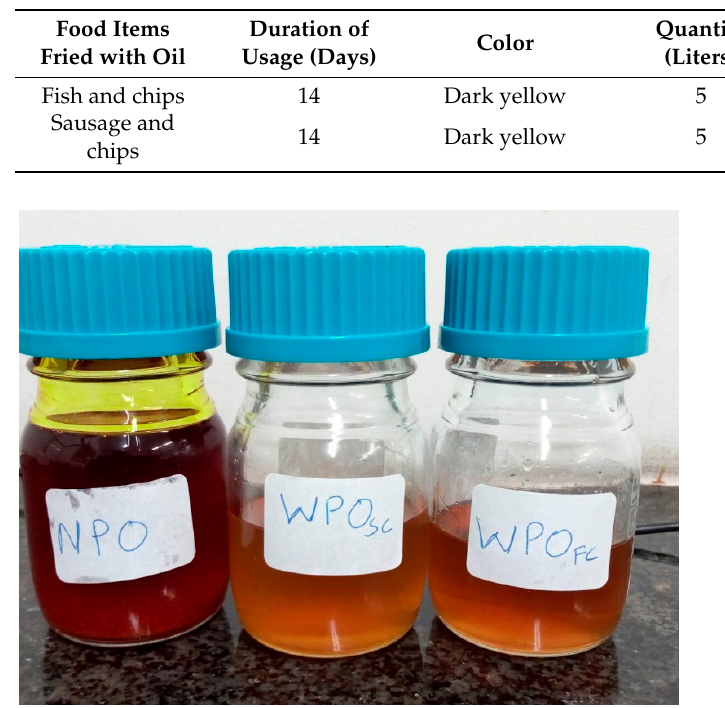
Figure 2. Picture of NPO, WPO SC and WPO FC samples.